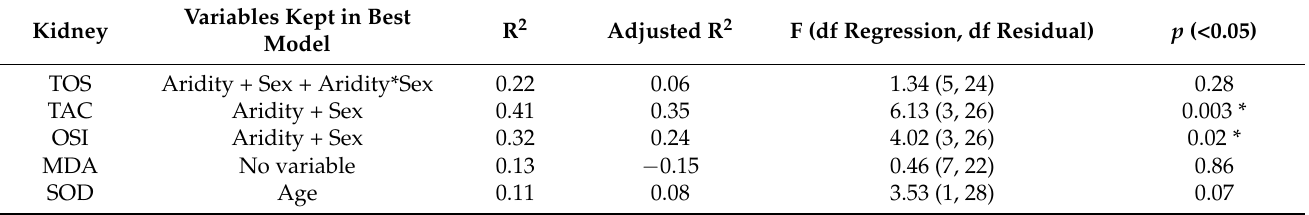
Table 1. The linear best model output for kidney oxidative markers, namely total oxidant status (TOS), non-enzymatic total antioxidant activity (TAC), oxidative stress index (OSI), malondialdehyde (MDA) and superoxide dismutase (SOD), for the common mole-rat ( Cryptomys hottentotus hottentotus ) in response to body mass, age, aridity, sex and the interaction between sex and aridity determined through backwards elimination based on the Akaike information